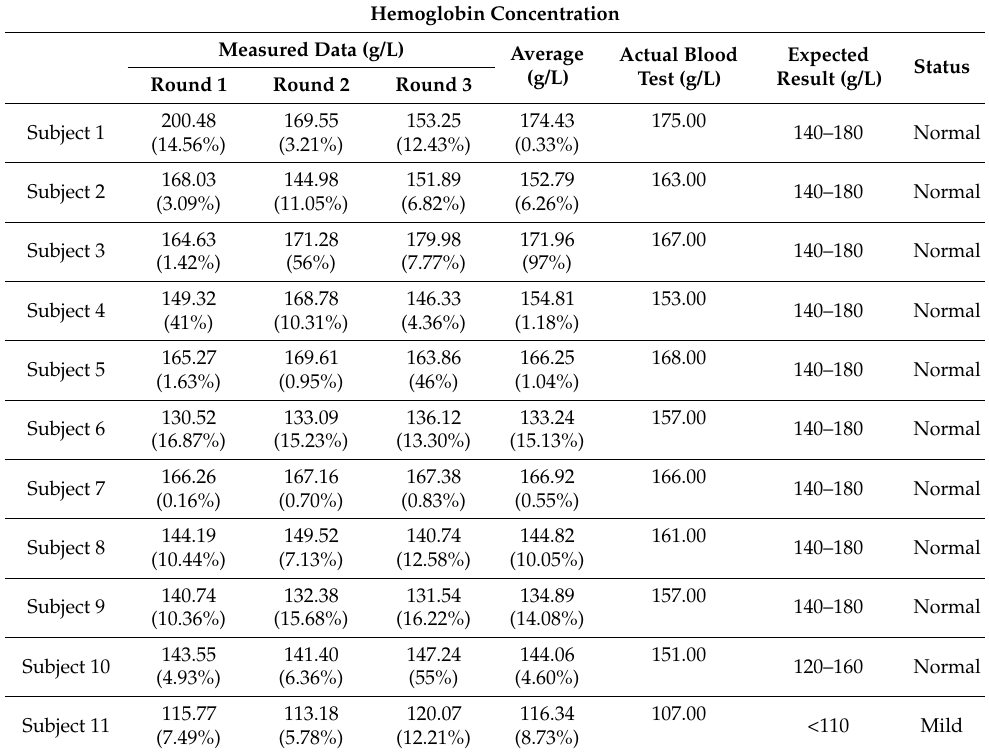
Table 9. Hemoglobin concentration measured data and expected